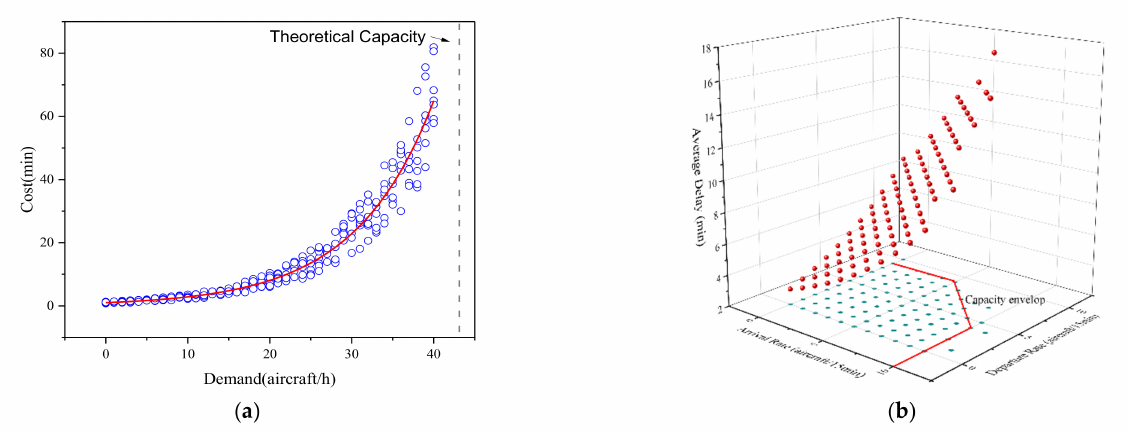
Figure 1. The fundamental diagram of runway congestion: ( a ) segregated mode; ( b ) mixed mode. Runways in segregated operation mode are used only for takeoff or only for landing, and there is no or very limited interaction between takeoff and landing operations. In this case, the landing or departure runway congestion cost is approximated as a univariate function of the landing rate a or takeoff rate d , denoted as Y A : a → C A